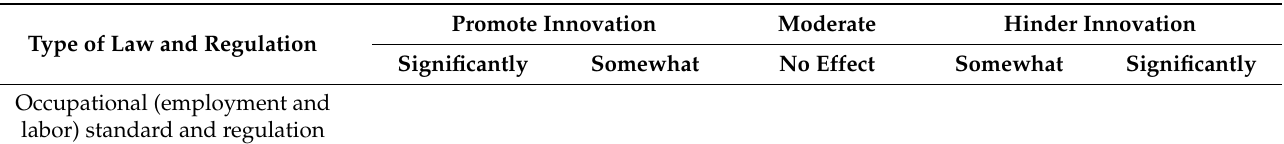
Table A1. Questionnaire of Korean innovation